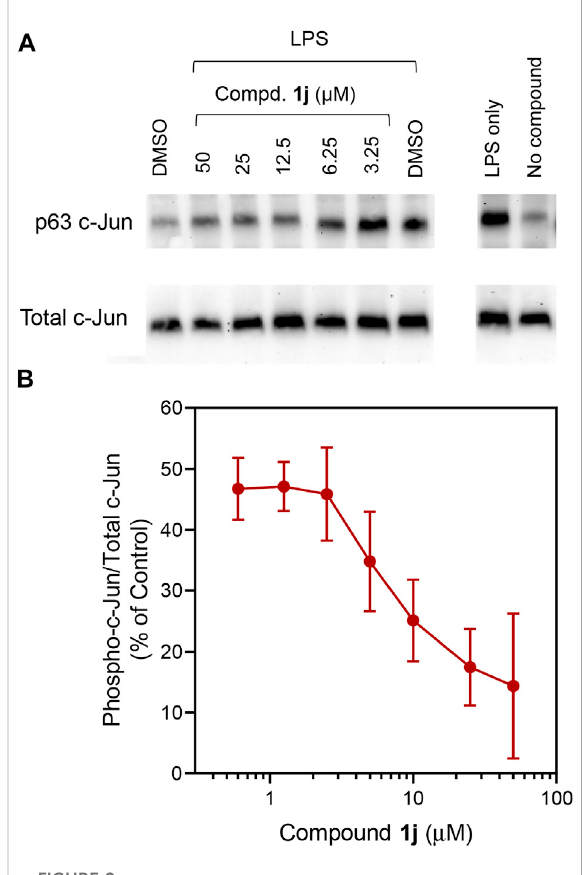
FIGURE 2 Effect of 1j on LPS-induced c-Jun (Ser63) phosphorylation. Human MonoMac-6 monocytic cells were pretreated with the indicated concentrations of compounds or 0.5% DMSO for 30 min, followed by treatment with LPS (250 ng/ml) or control buffer for another 30 min. Controls with cells alone (no DMSO)orcellstreatedwithLPSalonewerealsoincluded.Thecells were lysed, and the lysates were analyzed by Western blotting on 10% SDS-PAGE gels. A representative blotfrom three independent experiments is shown (A) . The blot was analyzed by densitometry as described under Materials and Methods , and the ratio of phospho- c -Jun/total c -Jun is shown in (B) . Values are expressed as mean ± SD of three independent experiments.